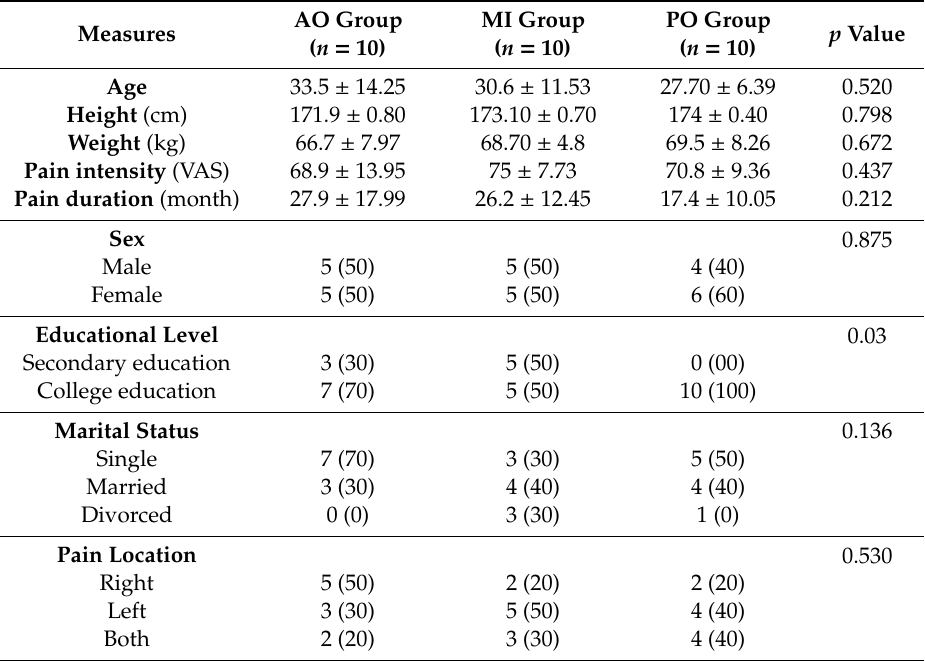
Table 1. Descriptive statistics of sociodemographic data.